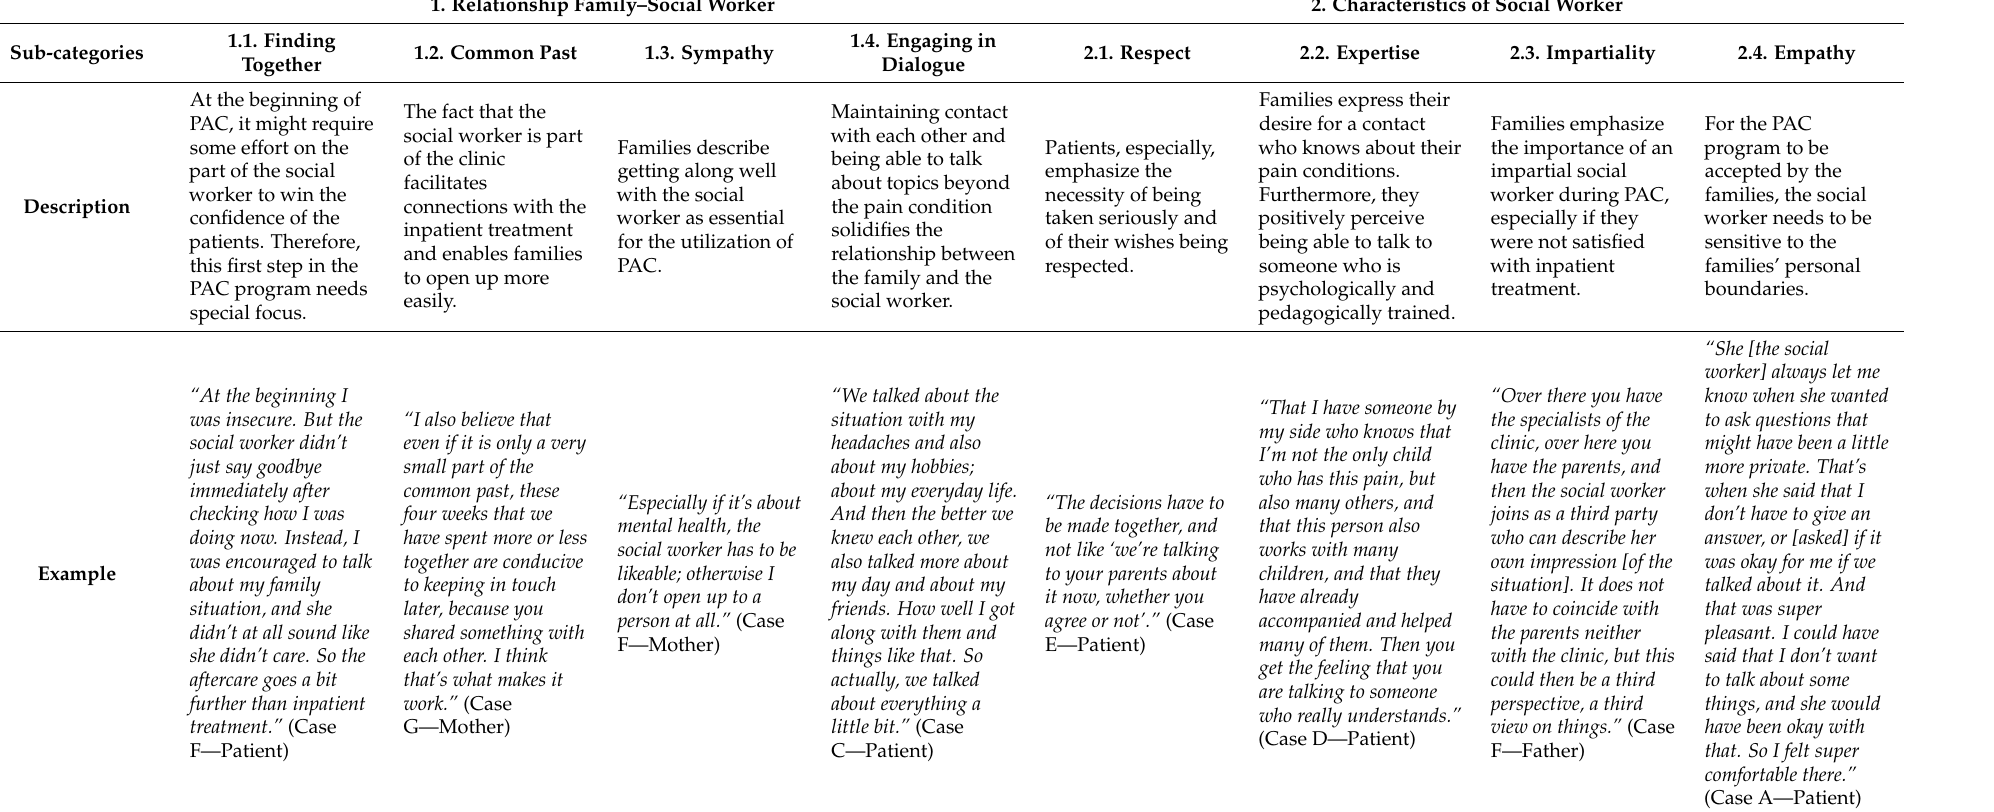
Table 3. Person factors of PAC: Subthemes and